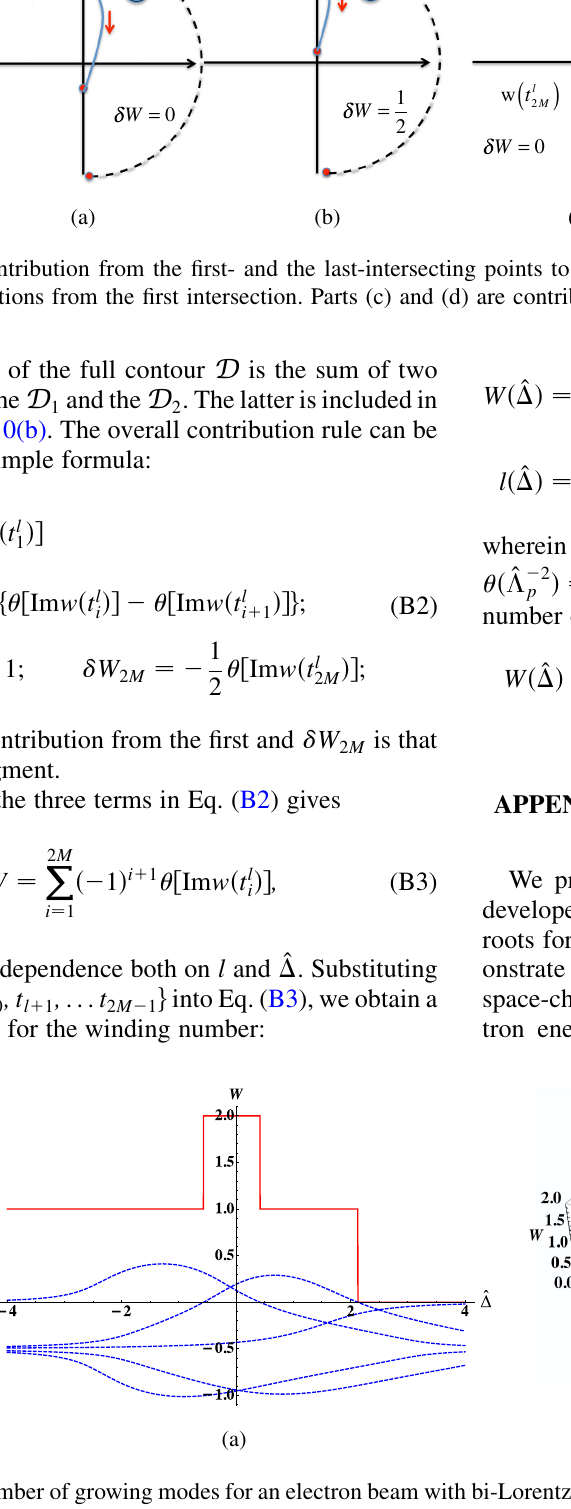
ffiffiffi p 3 , ^(cid:2) p ¼ 0 : 5 , and (cid:7) ¼ 0 : 5 . The blue curves are ffiffiffi p 3 and (cid:7) ¼ 0 : 5 .